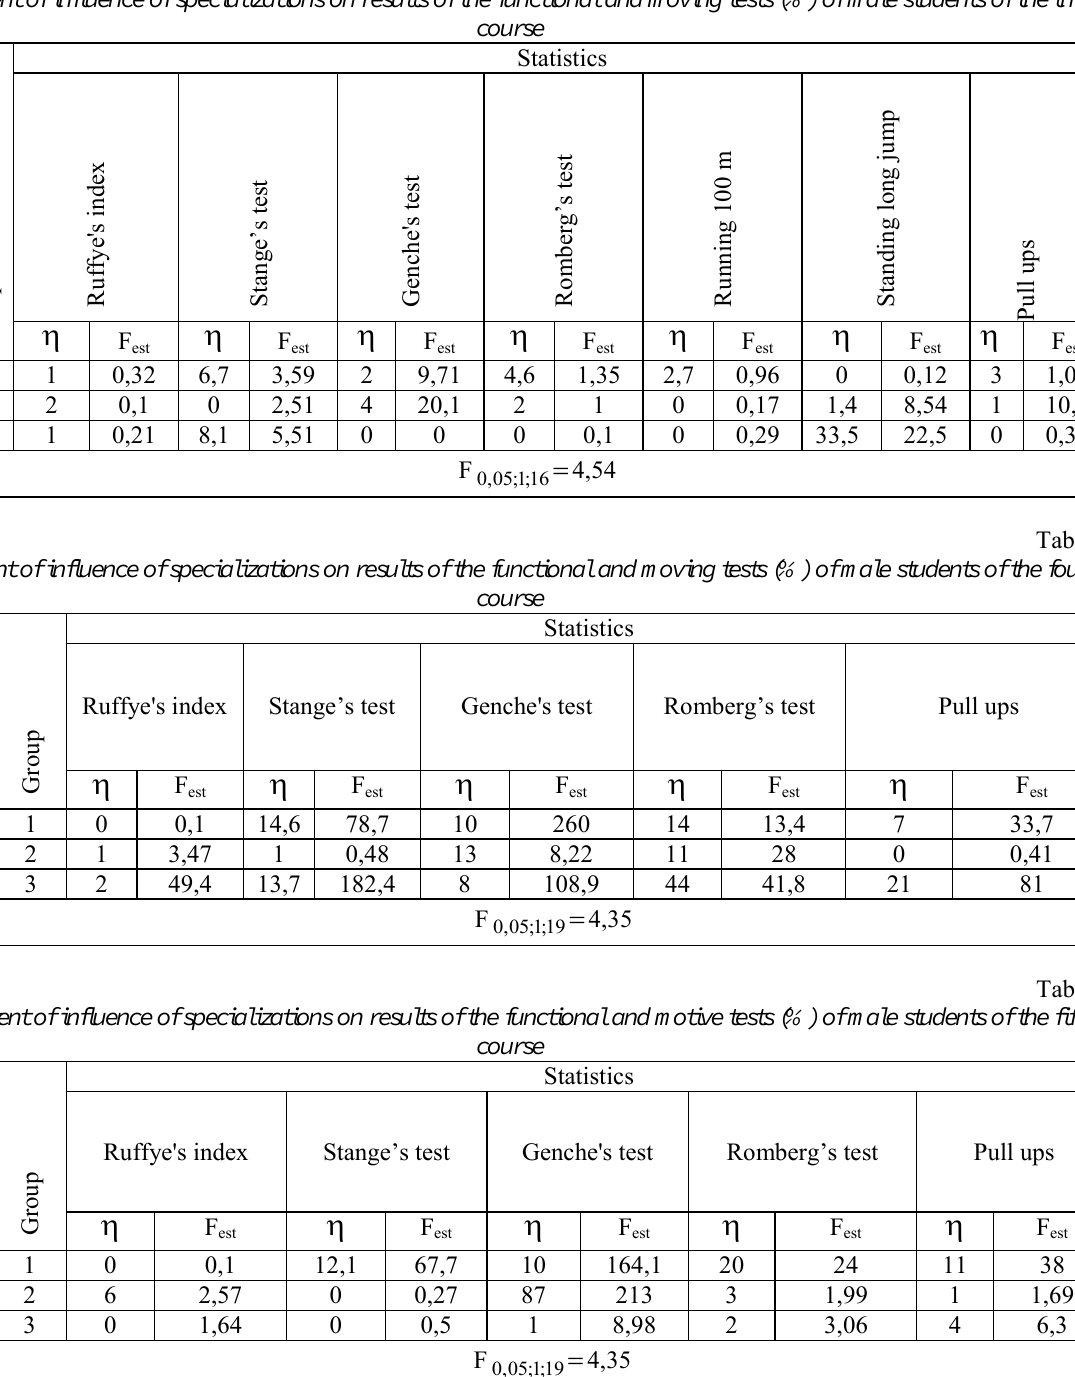
The extent of influence of specializations on results of the functional and moving tests (%) of male students of the third